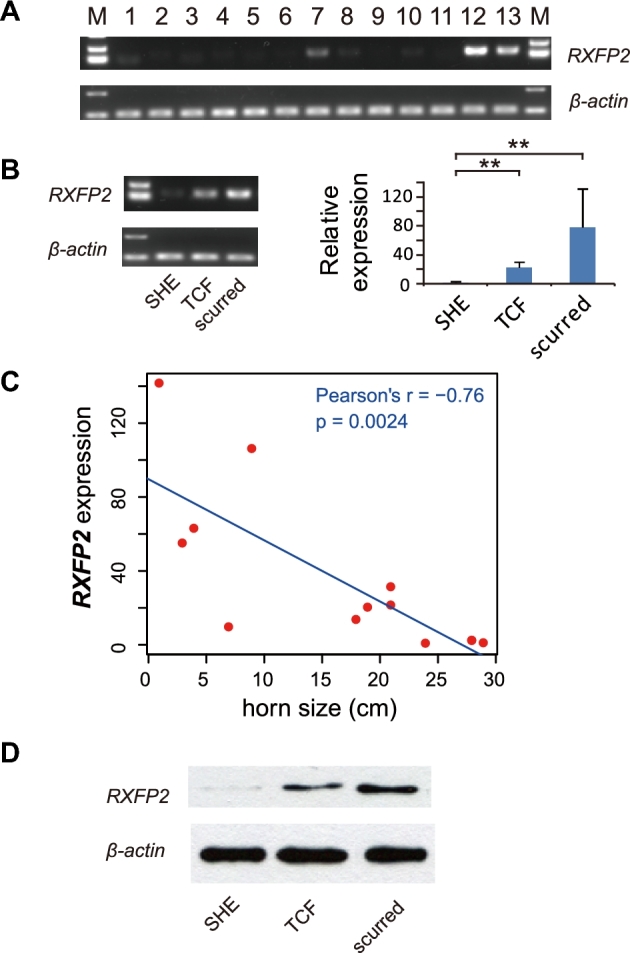
Gene expression patterns of RXFP2. a) Expression of RXFP2 and β-actin in 13 tissue samples from PT sheep: 1, heart; 2, liver; 3, spleen; 4, lung; 5, kidney; 6, muscle; 7, brain; 8, ovary; 9, corpus uteri; 10, adipose; 11, thyroid; 12, soft horn; and 13, horn periosteum. b) Expression pattern of RXFP2 in SHE-type, TCF-type, scurred soft-horn tissues examined by RT-PCR (left) and real-time PCR (right); error bars denote SD of the mean; groups with significant differences (*, P < 0.05; **, P < 0.001) are indicated. c) Scatter plot on RXFP2 expression and horn size; the fitting line of linear regression is shown in blue. d) Western blot analysis of soft-horn tissues with different horn types, using antibodies of RXFP2 and β-actin.